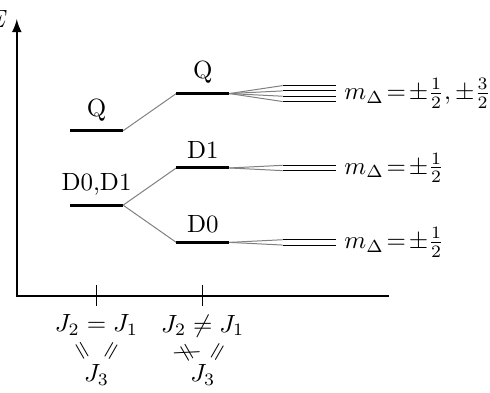
Figure 2: Spectrum of a single trimer with spin rotational symmetry. The 8 states belong to one quartet, Q, and two doublets, D0 and D1. The doublets are degenerate = J = J if and only if J 1 2 3